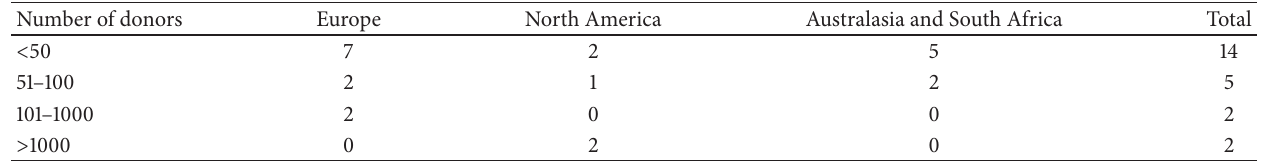
Table 10: Number of donors processed by HVBs, according to geographical region.